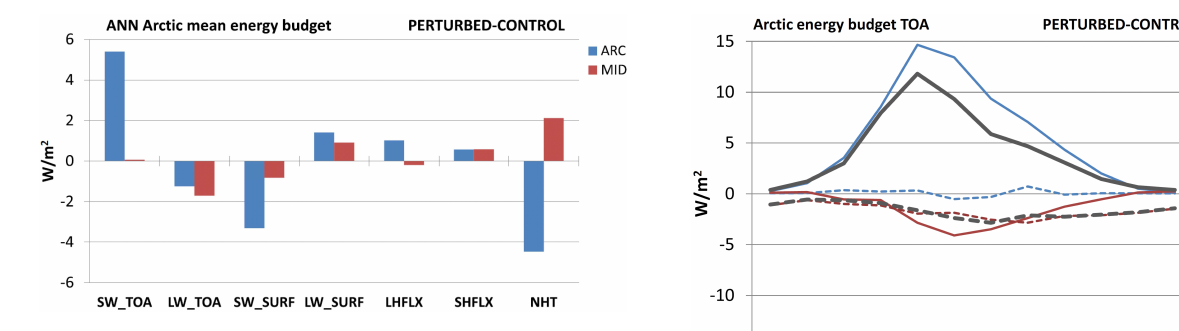
Fig. 11. Difference in the annual mean Arctic atmospheric energy budget terms for the ARC-CONTROL (blue) and MID-CONTROL (red). All units in Wm − 2 . SW TOA and LW TOA are the net SW and LW radiation fluxes at TOA; SW SURF and LW SURF are the net SW and LW radiation fluxes at the surface; LHFLX and SHFLX are the latent and sensible heat fluxes and NHT is the net atmo- spheric heat transport. All units in Wm − 2 .